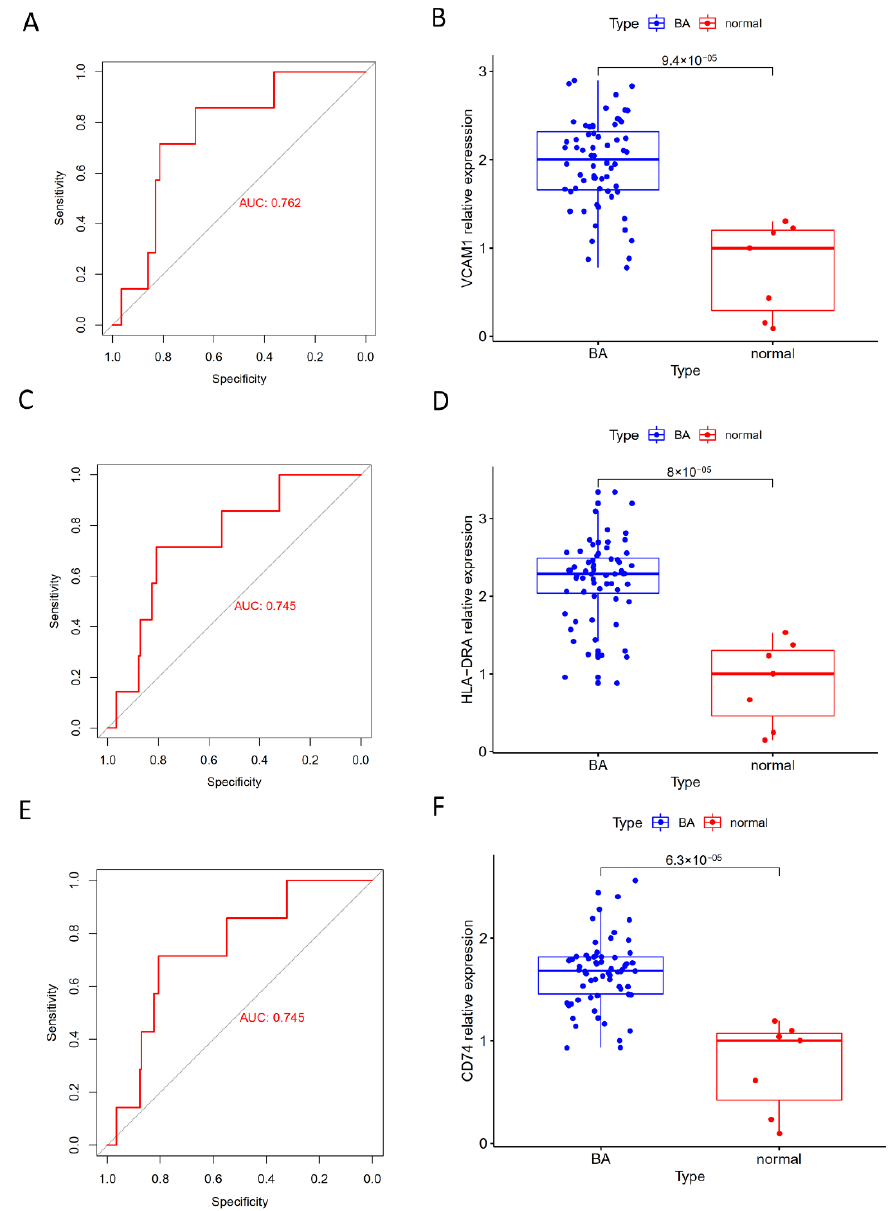
Figure 6. ROC curves of the three hub IRGs in the training cohort and verification of the validation cohort. ( A ) ROC curve of VCAM1 in GSE122340. ( B ) Differences in VCAM1 in GSE46960. ( C ) ROC curve of HLA-DRA in GSE122340. ( D ) Differences in HLA-DRA in GSE46960. ( E ) ROC curve of CD74. ( F ) Differences in CD74 in GSE46960.